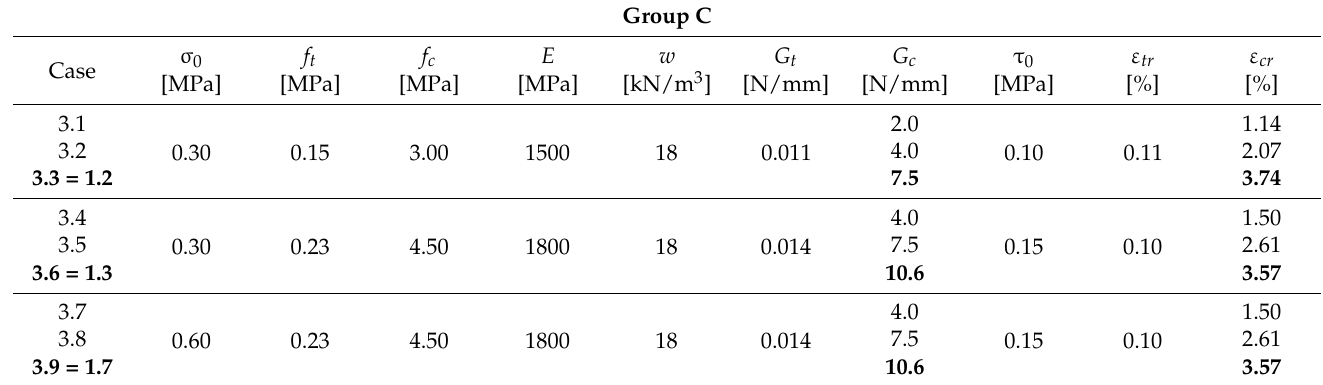
Table 5. Mechanical properties used in the sensitivity analyses for Group C. Group C